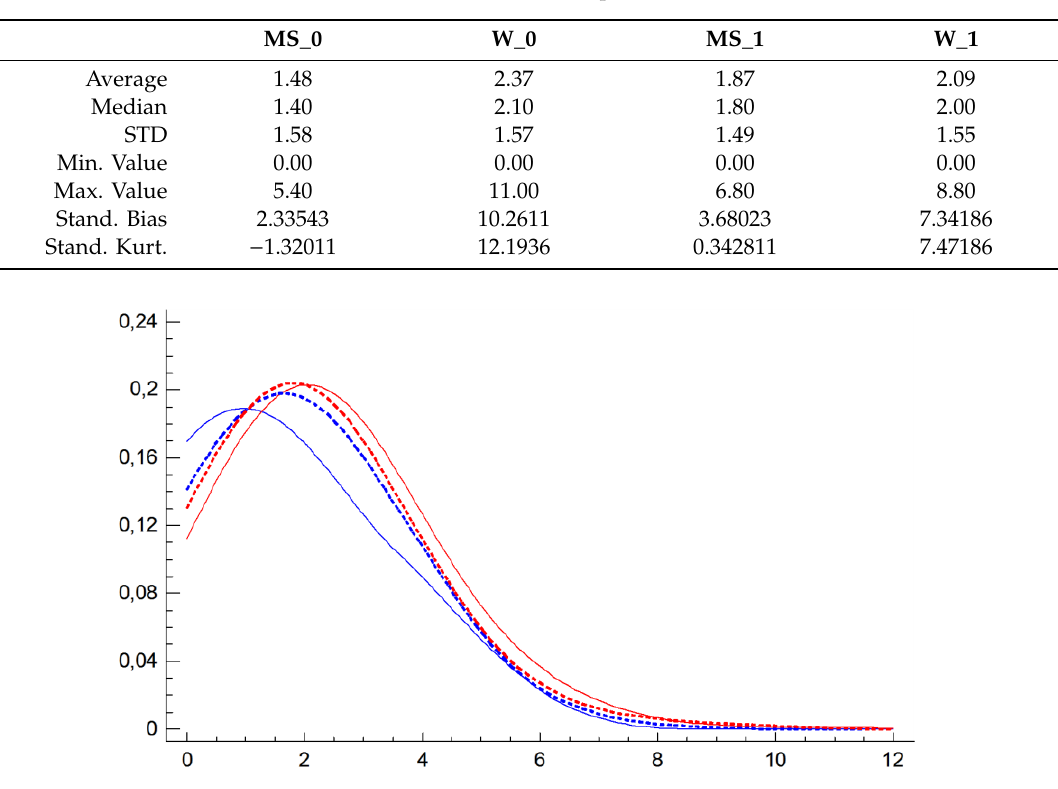
Figure 11. Probabilistic density trace distribution for individual symptoms’ scores (winter, red; middle season, blue; windows closed, solid line; windows open, dashed line).